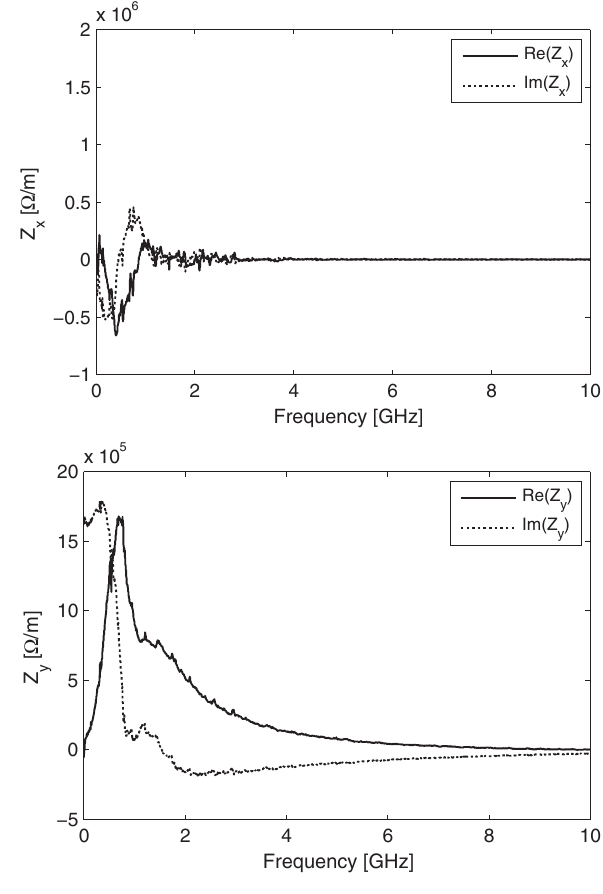
FIG. 6. Total horizontal and vertical impedance of the PS kickers (sum of dipolar and quadrupolar components), weighted for the β -function, computed with CST Particle